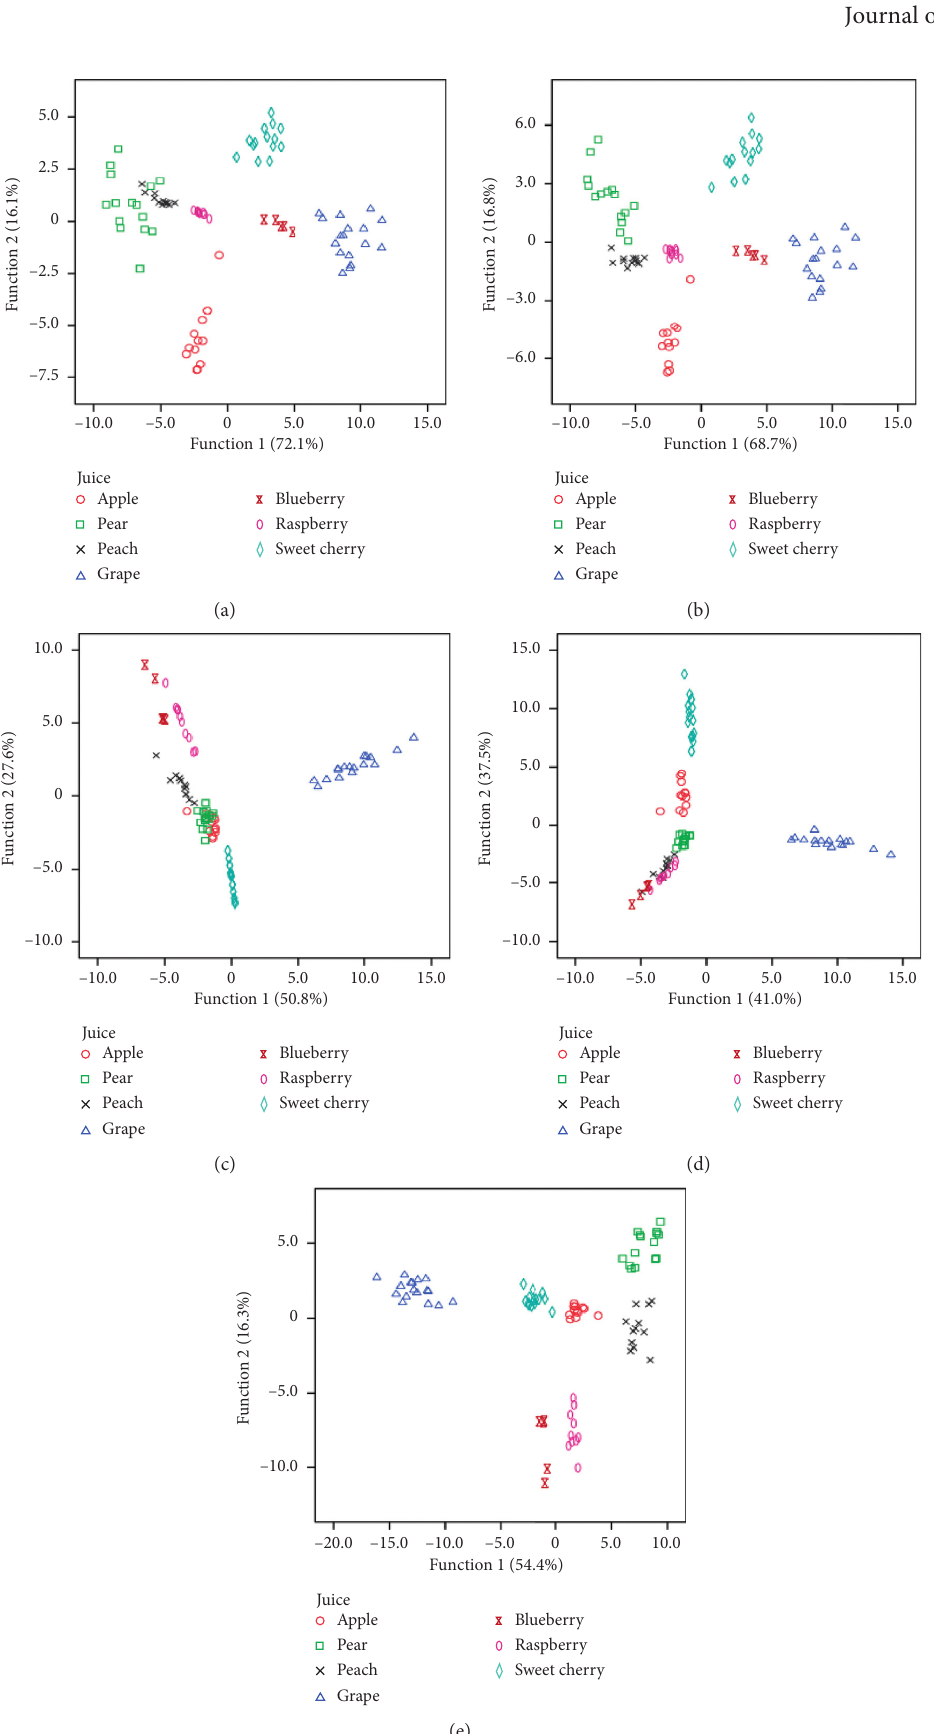
Figure 2: Score plots of Function 1 vs. Function 2 obtained with all analyzed samples used as analytical data for LDA: (a) sugar content; (b) sugar content combined with Fru/Glu; (c) organic acid content; (d) organic acid content combined with malic/citric; (e) sugar content combined with organic acid